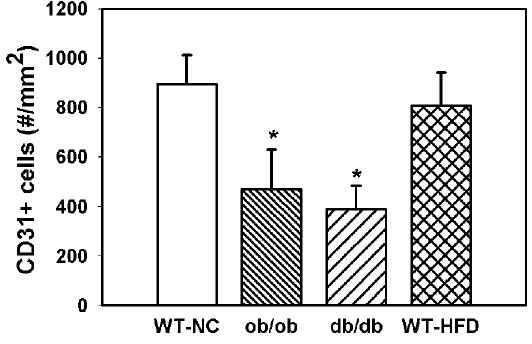
FIGURE 4. Angiogenesis following muscle injury is impaired in ob/ob and db/db mice. Injured muscles collected from WT mice fed NC, ob/ob mice, db/db mice, and WT mice fed HFD. Summary data for angiogenesis assessed on day 5 postinjury by immunostaining for the endothelial cell–specific CD31 antigen, counting number of CD31+ cells per cryosection, and normalizing to muscle area. Bars are means ± standard error, n = 4–6 per time point. *= Mean value significantly smaller than that for WT-NC mice; p <